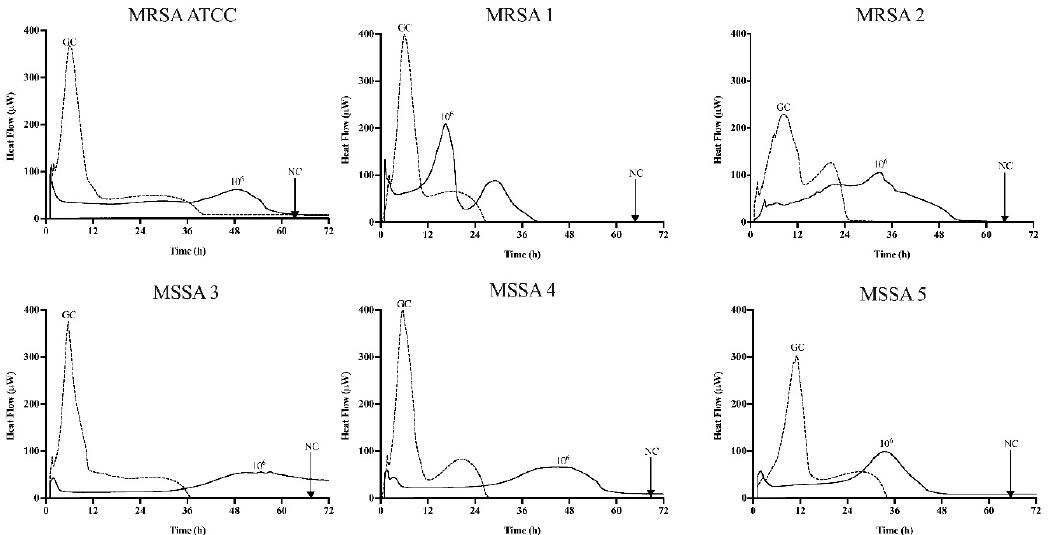
Figure 2. Microcalorimetry analysis of MRSA ATCC 43300 and five rifampin-resistance S. aureus biofilms inhibited by Sb-1. Each curve shows the heat produced by viable bacteria presented in the biofilm after 24 h of exposure to Sb-1. Numbers represent concentrations of Sb-1 (in PFU/mL). GC, growth control; NC, negative control. Data of a representative experiment are reported.